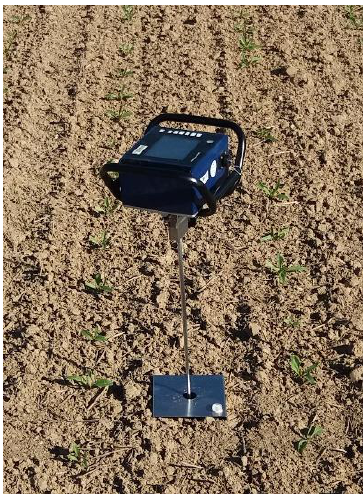
Figure 2. Photograph of the used penetrologger.